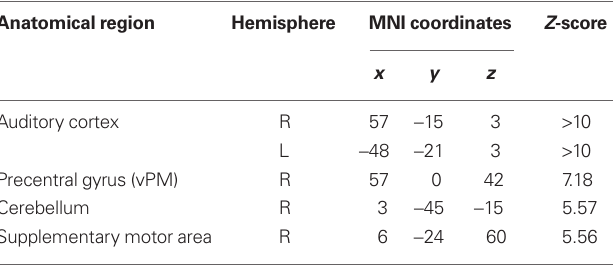
Table 2 | Common brain activation during the perception of improvised and imitated melodies (conjunction analysis).